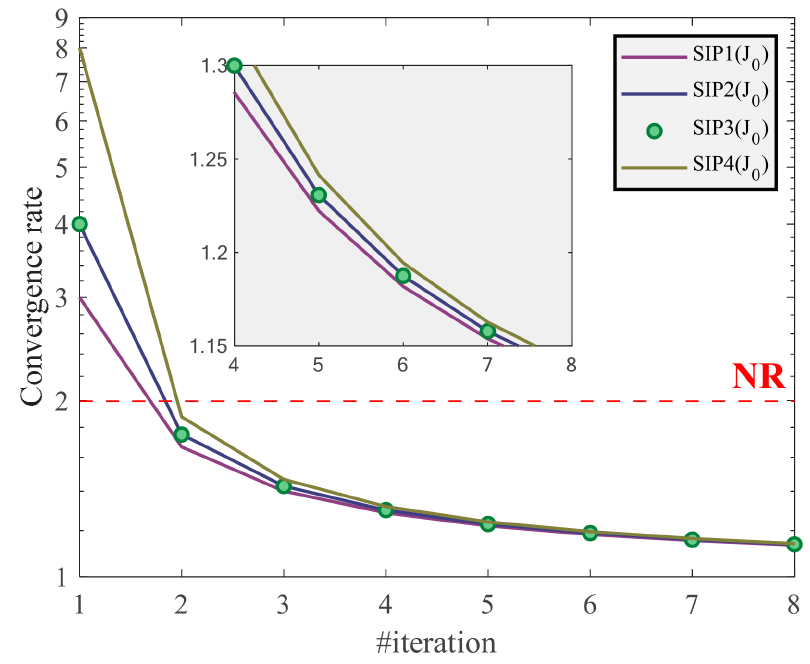
Figure 1. Convergence rates of the algorithms